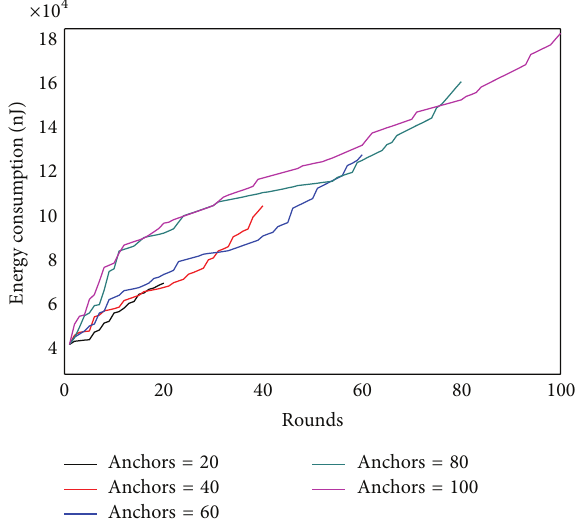
Figure 25: Maximum energy consumption under different numbers of anchor (experimental value).